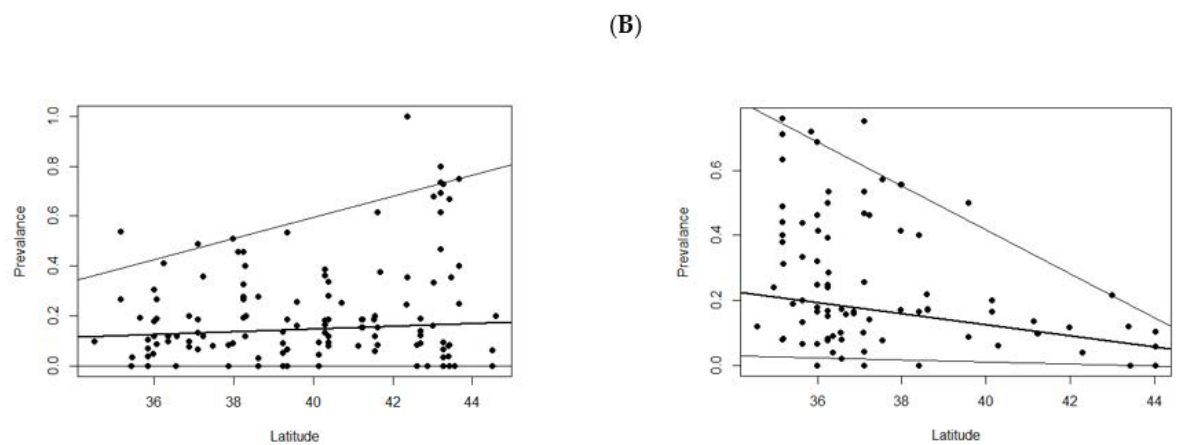
Figure 2. Patterns of weevil prevalence in acorns of ( A ) Q. rubra and ( B ) Q. alba across all years of the study. Note that the weevil prevalence increased with latitude in Q. rubra whereas the opposite was true for Q. alba . Statistical analyses en-tailed a percentile regression based on the 2.5, 50 (median) and 97.5 percentiles. For Q. rubra , for example, in lower lat- itudes prevalence is consistently low (between 0 and 35%) and with progression northward the 97.5 percentile expands as trees show much higher levels of maximal infestation. Note the opposite in Q. alba . Also note that in both species the 2.5 and 50 percentiles are relatively constant across latitude, whereas the 97.5 percentile changes significant but in opposite directions for the two species. 95% confidence intervals are defined by the two lighter lines whereas the darker line in the middle represents the median.